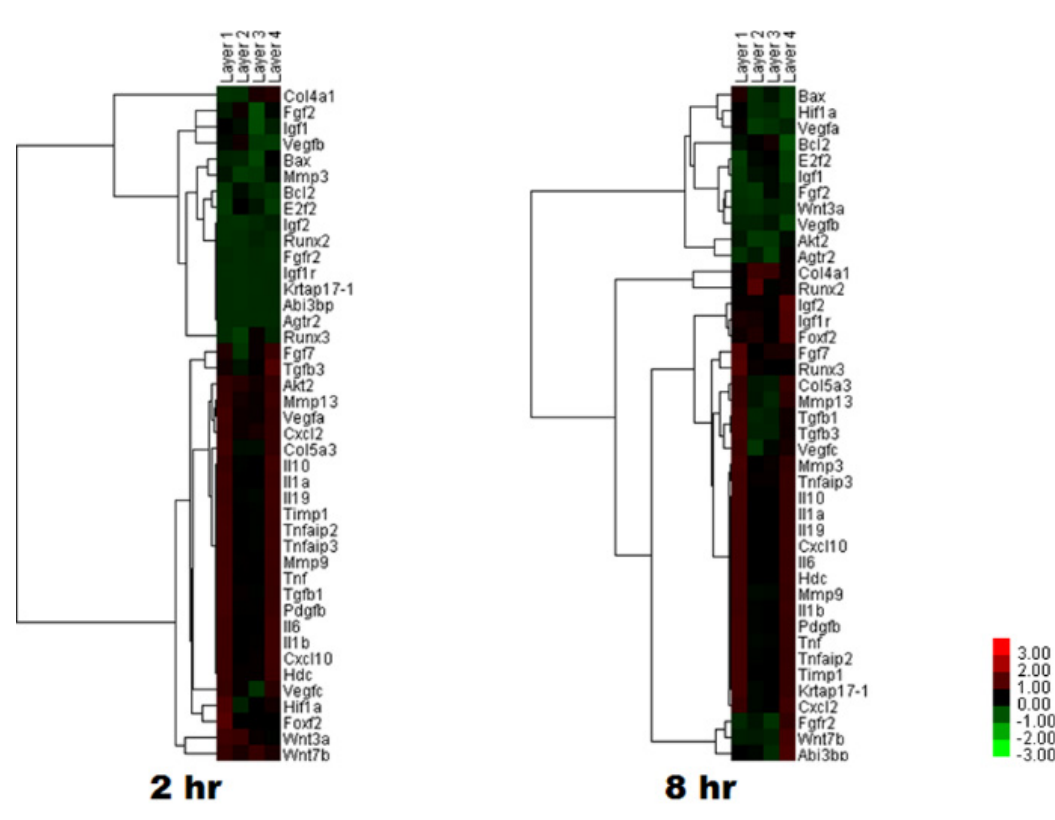
Figure 6. cDNA microarray analysis. The application of soluble proteins from a silk mat changed the expression levels of genes after 2 h and 8 h. Layer 1 was obtained from the innermost layer of silkworm cocoon, and Layer 4 from the outermost layer (Reproduced from a published article [74] with permission).